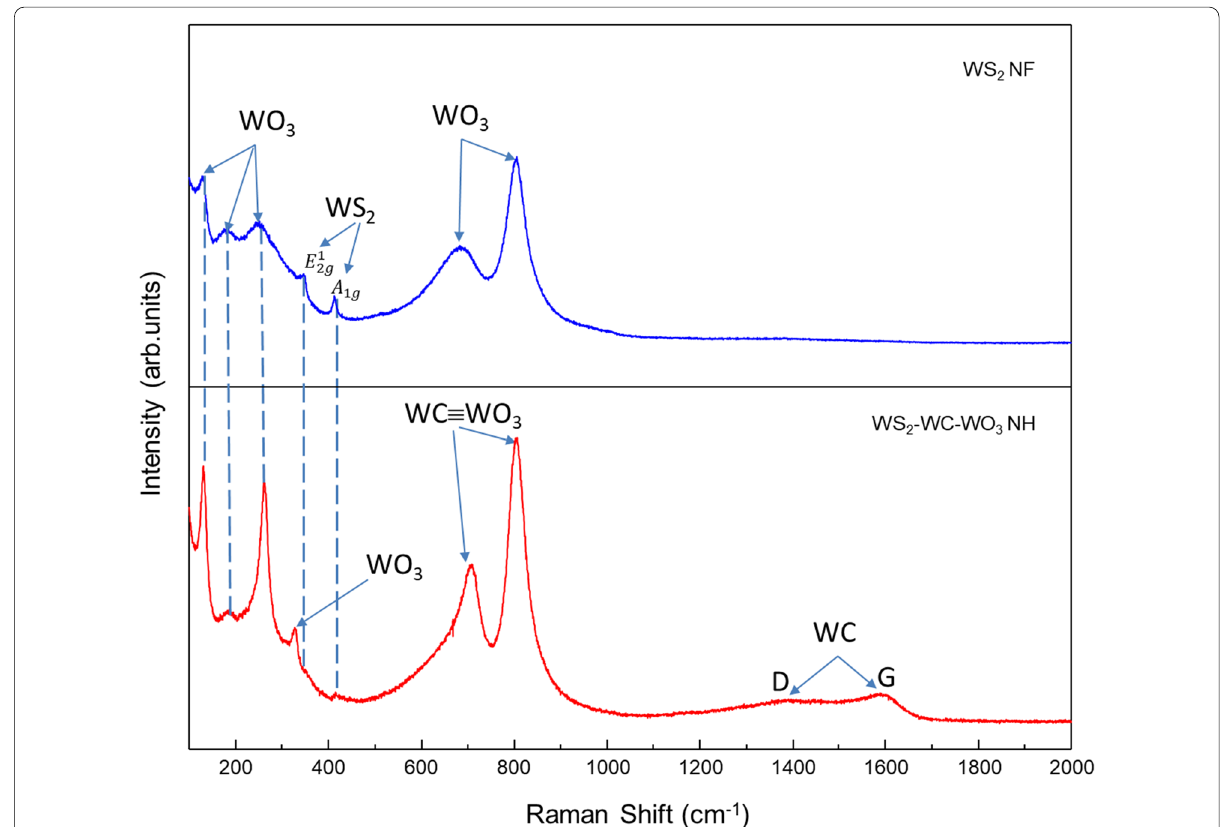
Fig. 3 Raman spectra of the WS 2 NFs and WS 2 –WC-–WO 3 NH